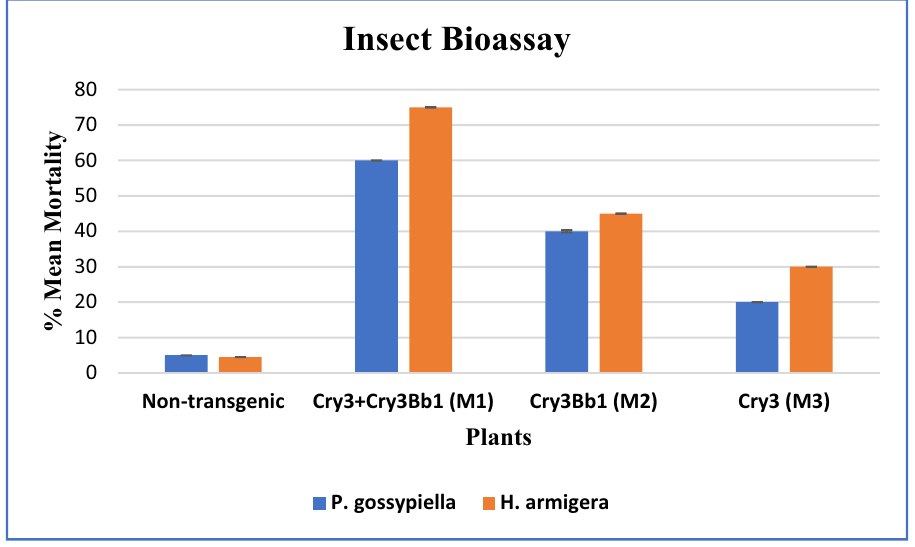
Figure 6. Relative expression of cry genes in three transgenic cotton plants (M1, M2, and M3). The relative expression of cry genes, analyzed in different plants shown in the figure was calculate according to the 2 (−ΔΔCt) method using GAPDH as internal control reference gene for